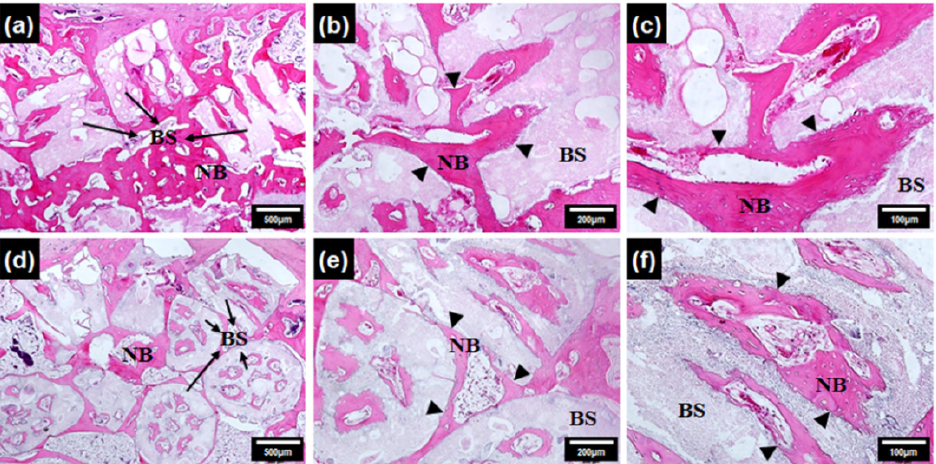
Figure 3. H&E-stained tissue section of granular bone substitute implanted bone areas. ( a – c ) Bone formation after 1 month of implantation with 1 mm granule. ( d – f ) bone formation after 2 months of implantation. Legend: BS (Bone substitute), NB (New